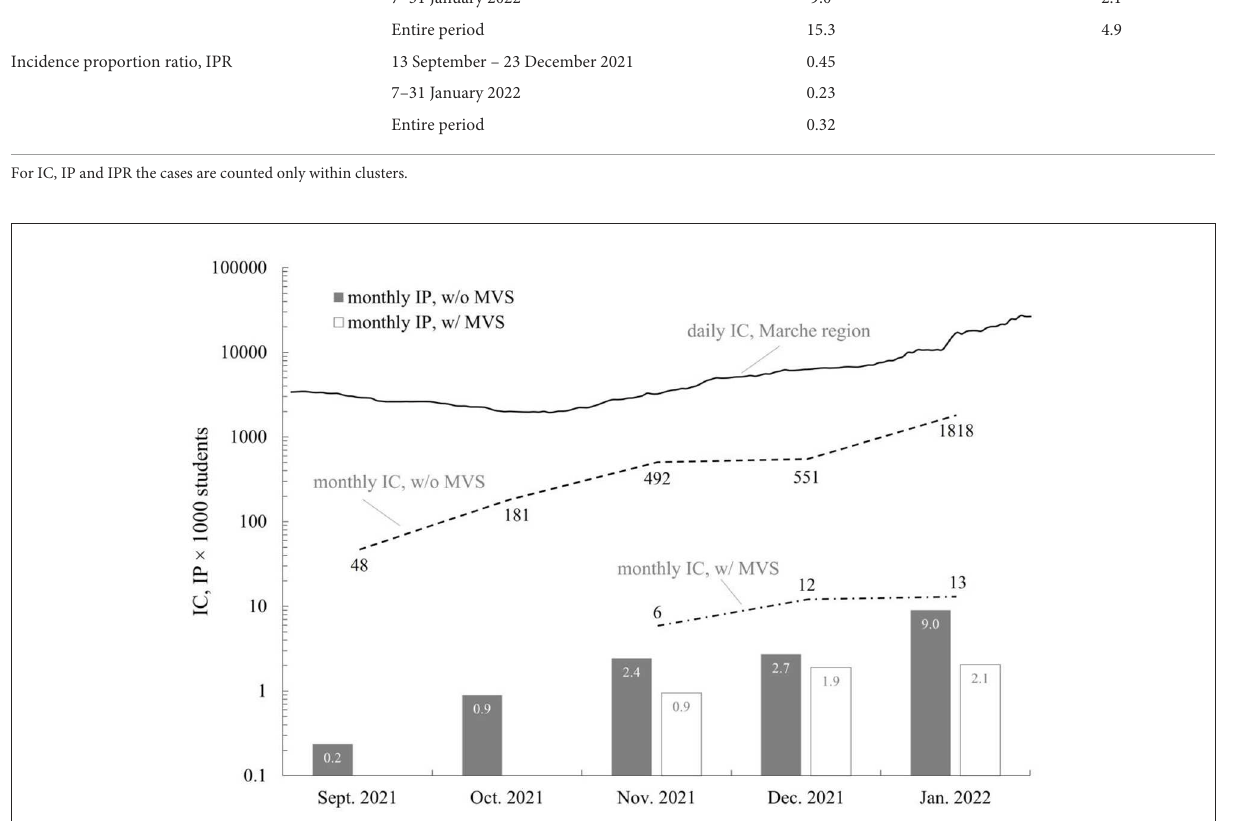
FIGURE1 Daily cases in the Marche region, monthly incidence cases (IC) and incidence proportion (IP, per 1000 students) in classrooms with (w/) and without (w/o) mechanical ventilation systems (MVSs) from September 2021 to January 2022. For IC and IP the cases are counted only within